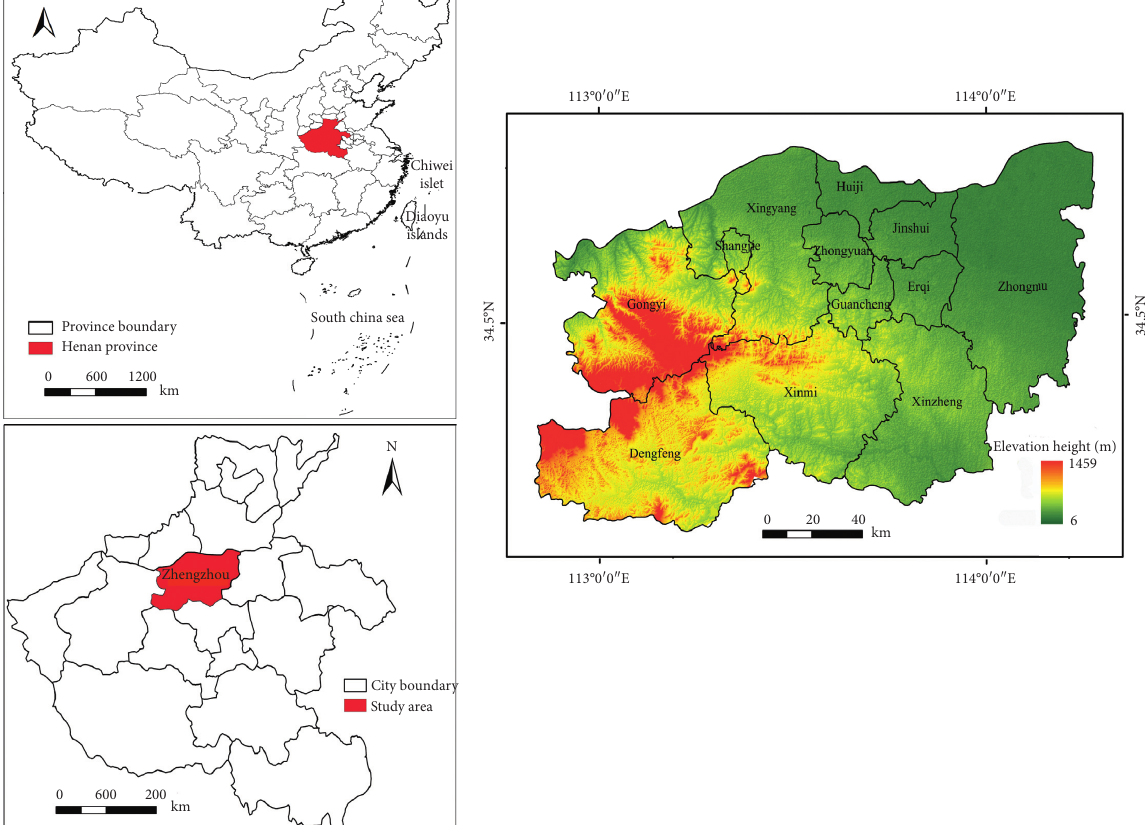
Figure 1: The location of study